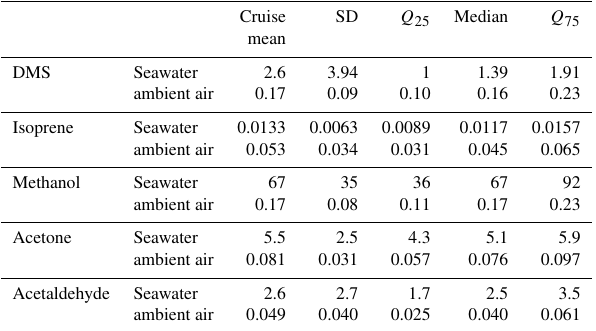
Table 2. Cruise mean seawater concentration (nmoldm − 3 ) and am- bient air mixing ratio (ppbv). Cruise median and quantiles ( Q 25 and Q 75 ) are also indicated as well as the standard deviation (SD).